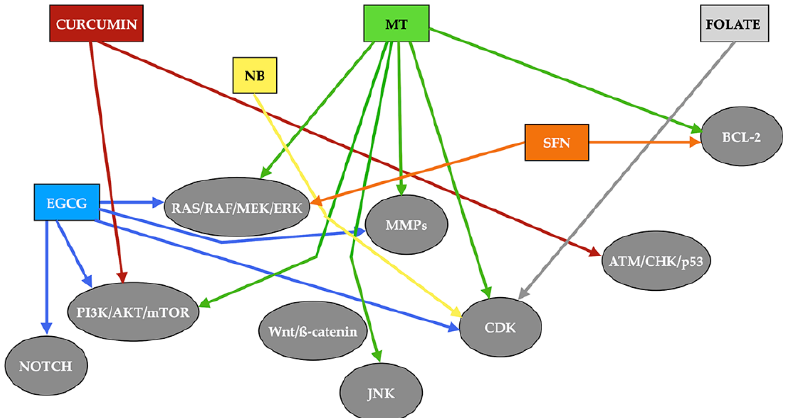
Figure 4. Signaling pathways stimulated by different epidrugs. Rectangles of different colors indicate each of the drugs analyzed, while arrows with the same color as the rectangle from which they indicate the signals induced by each of the drugs. MT: melatonin. NB: sodium butyrate. ECGC: epigallocatechin-3-gallate. SFN: sulforaphane. MMPs: matrix metalloproteinases. CDK: cyclin- dependent kinase. ATM: ataxia telangiectasia mutated. CHK: check point kinase.